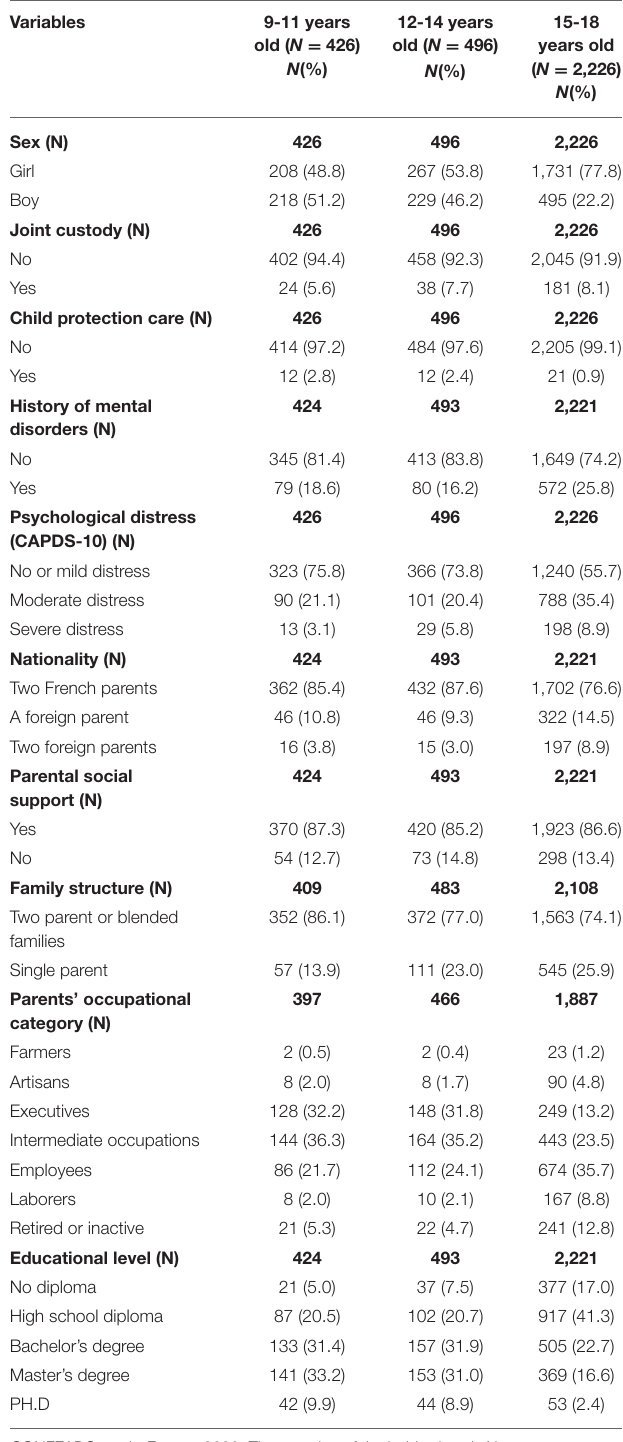
TABLE 1 | Sample characteristics ( N =